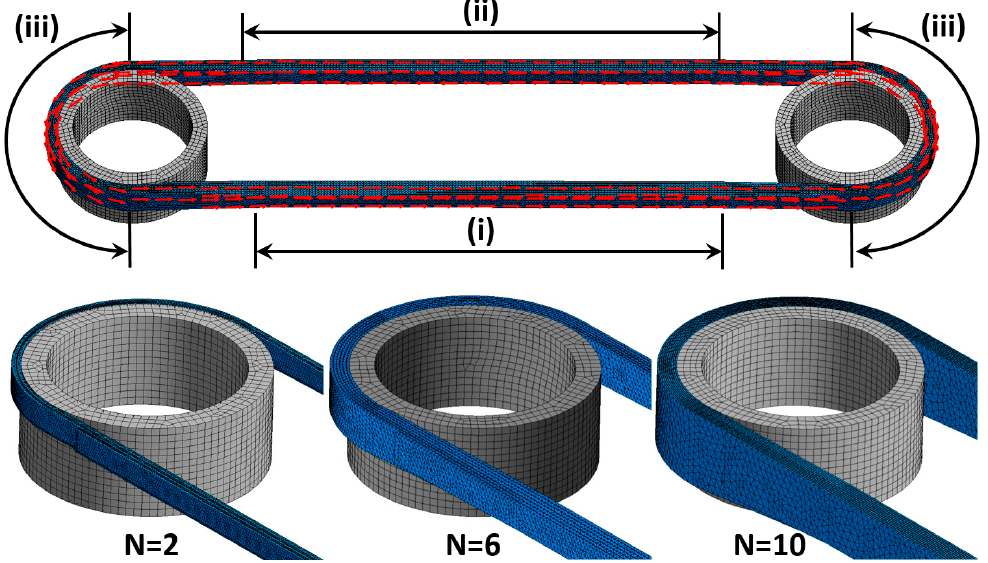
Figure 7. Meso-models of the simple loops: fiber orientation and characteristic areas ( top ), close-up view of insert area ( bottom ). windings’ rectangular